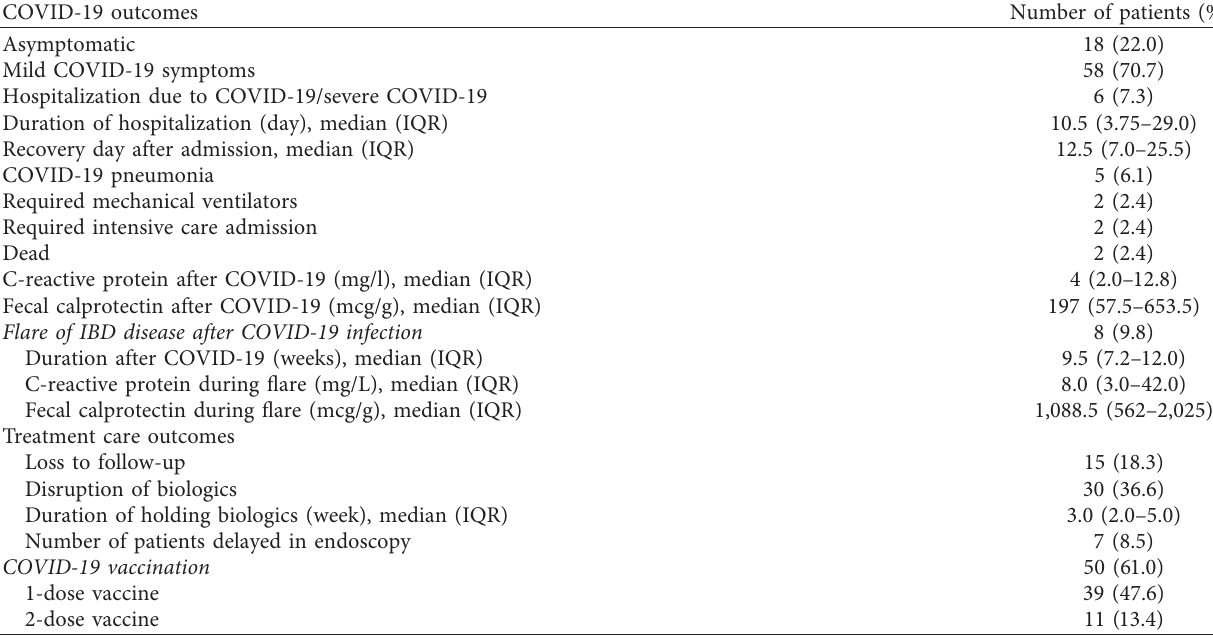
Table 2: Outcome of COVID-19 in IBD patients, disease course of IBD, and vaccination after COVID-19 infection. COVID-19 outcomes